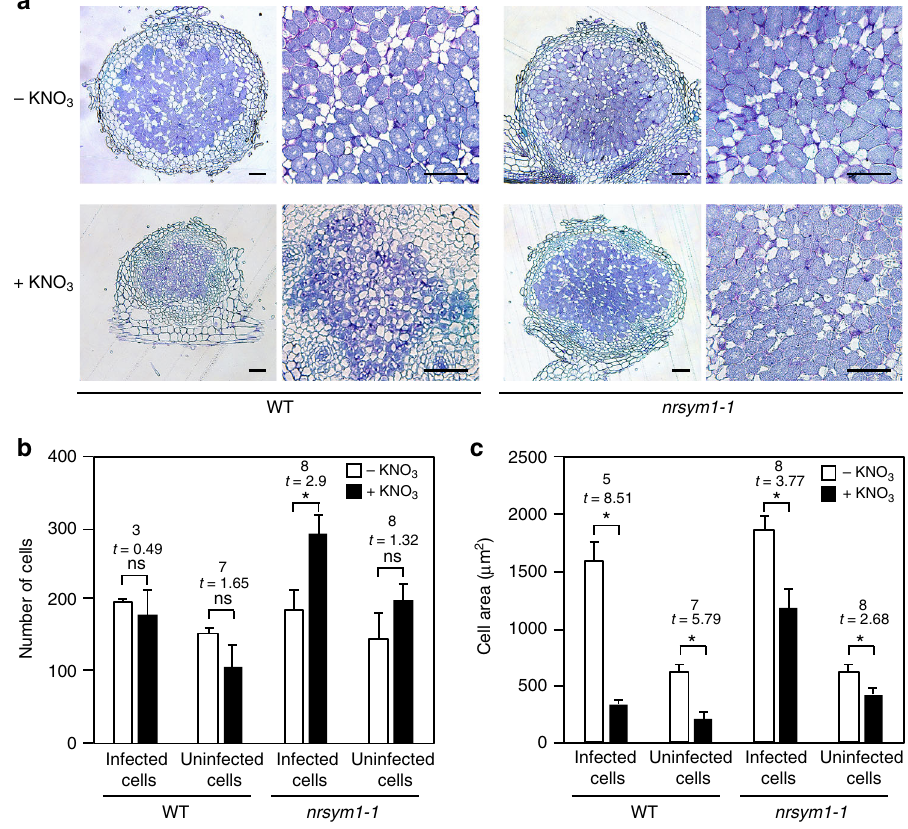
Fig. 2 The effect of nitrate on nodule growth. a Sections through 21 dai nodules of WT and the nrsym1-1 mutants grown in the presence of 0 or 10 mM KNO 3 . Sections were stained with toluidine blue. Scale bars: 100 μ m. b The number of cells and ( c ) the cell area ( μ m 2 ) in the inner region of nodule sections. After images of individual nodule sections of maximum diameter had been collected, cell number and cell area were measured using ImageJ software (http://imagej.nih.gov/ij/; n = 4 – 5 nodule section). Infected and uninfected cells located in the inner region of nodule parenchyma were scored for the presence or absence of cell staining, respectively. To calculate cell area, the area of all infected and uninfected cells was measured and averaged (170 – 637 cells per nodule section). Using the obtained average cell area in respective nodule sections, the average cell area per nodule section was calculated. * P < 0.05 by Student ’ s t -test. ns, not signi fi cant. Degrees of freedom are shown above the t -values. Error bars indicate